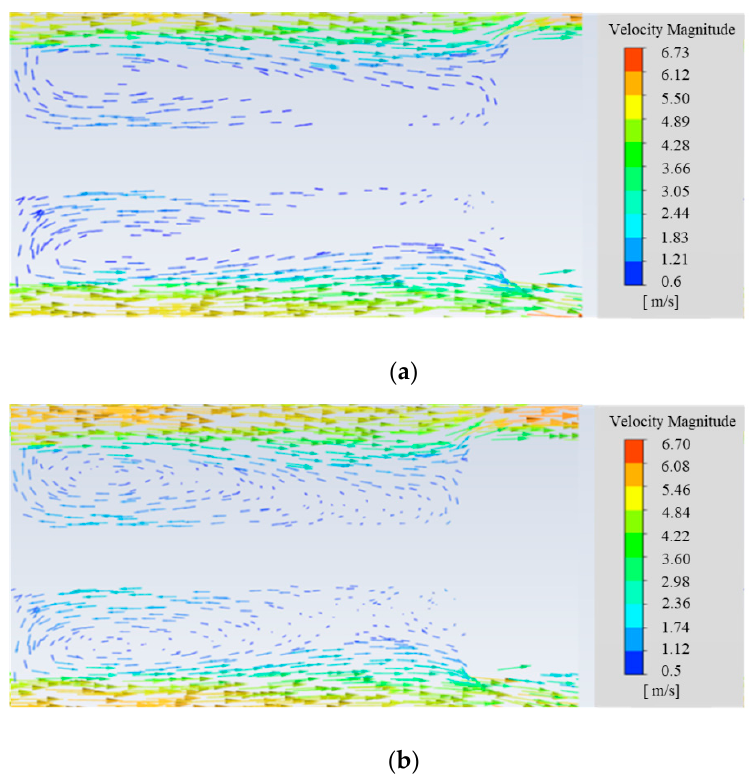
Figure 19. Comparison of internal fluid velocity traces. ( a ) Before optimization internal velocity distribution. ( b ) The optimized internal velocity distribution.